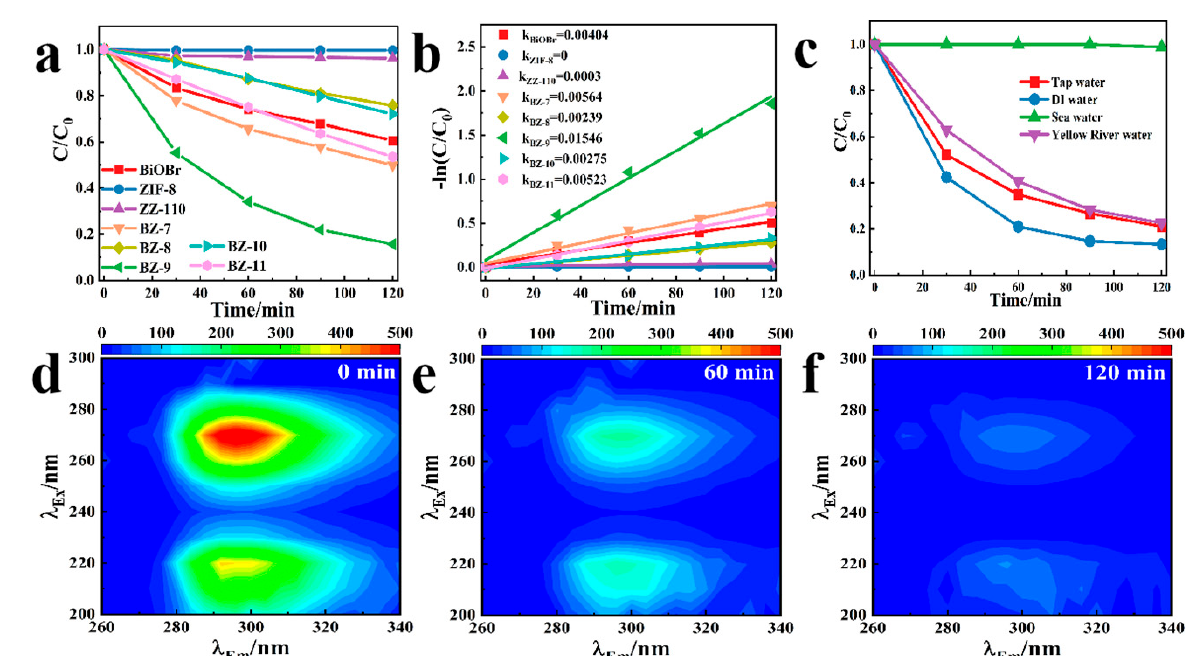
Figure 5. Phenol degradation of the preparation materials ( a ), and the corresponding pseudo first order dynamics curve ( b ); Phenol degradation in natural water bodies by using BZ − 9 ( c ); 3D EEMs of Phenol ( d – f ).